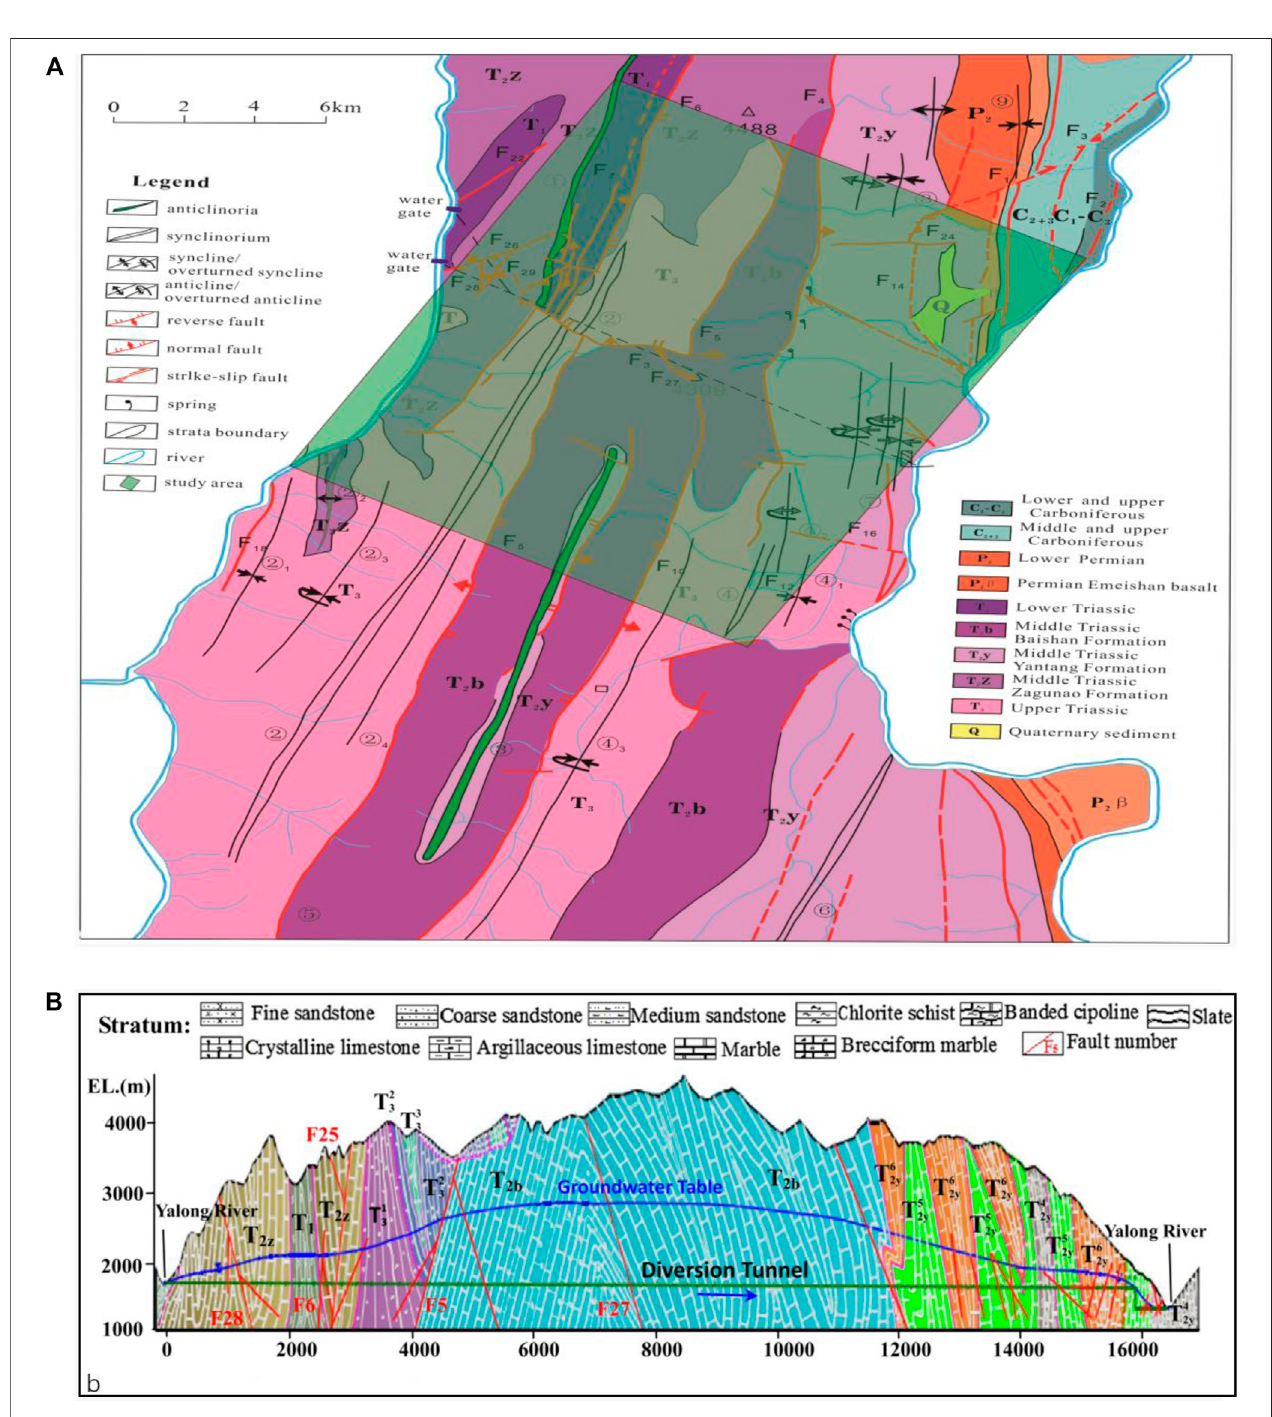
FIGURE 3 | Geological map of the study areas (A) and cross section of the No.1 headrace tunnel (B) (Hou et al., 2016).